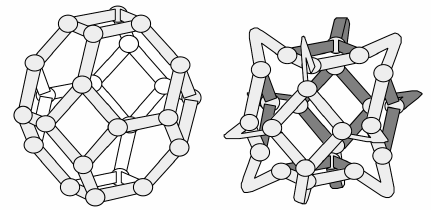
Figure 1. Geometry of conventional tetrakaidec- ahedron (left) and re-entrant tetrakaidecahedron (right)